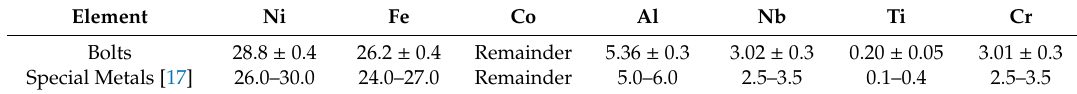
Table 1. Chemical compositions of Inconel 783 alloy bolts (mass fraction %).